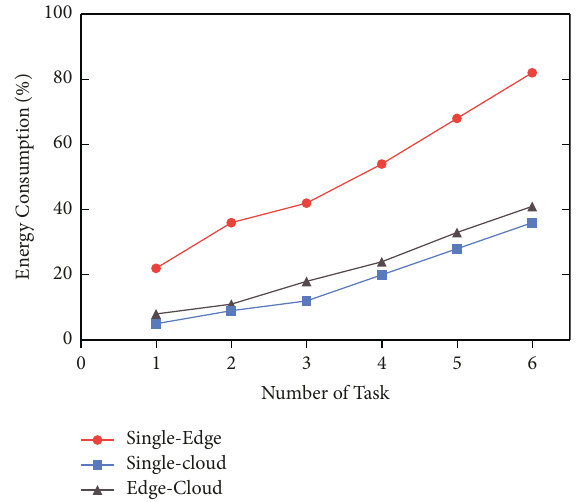
Figure 4: Comparison of energy consumption of the three schemes under the same number of